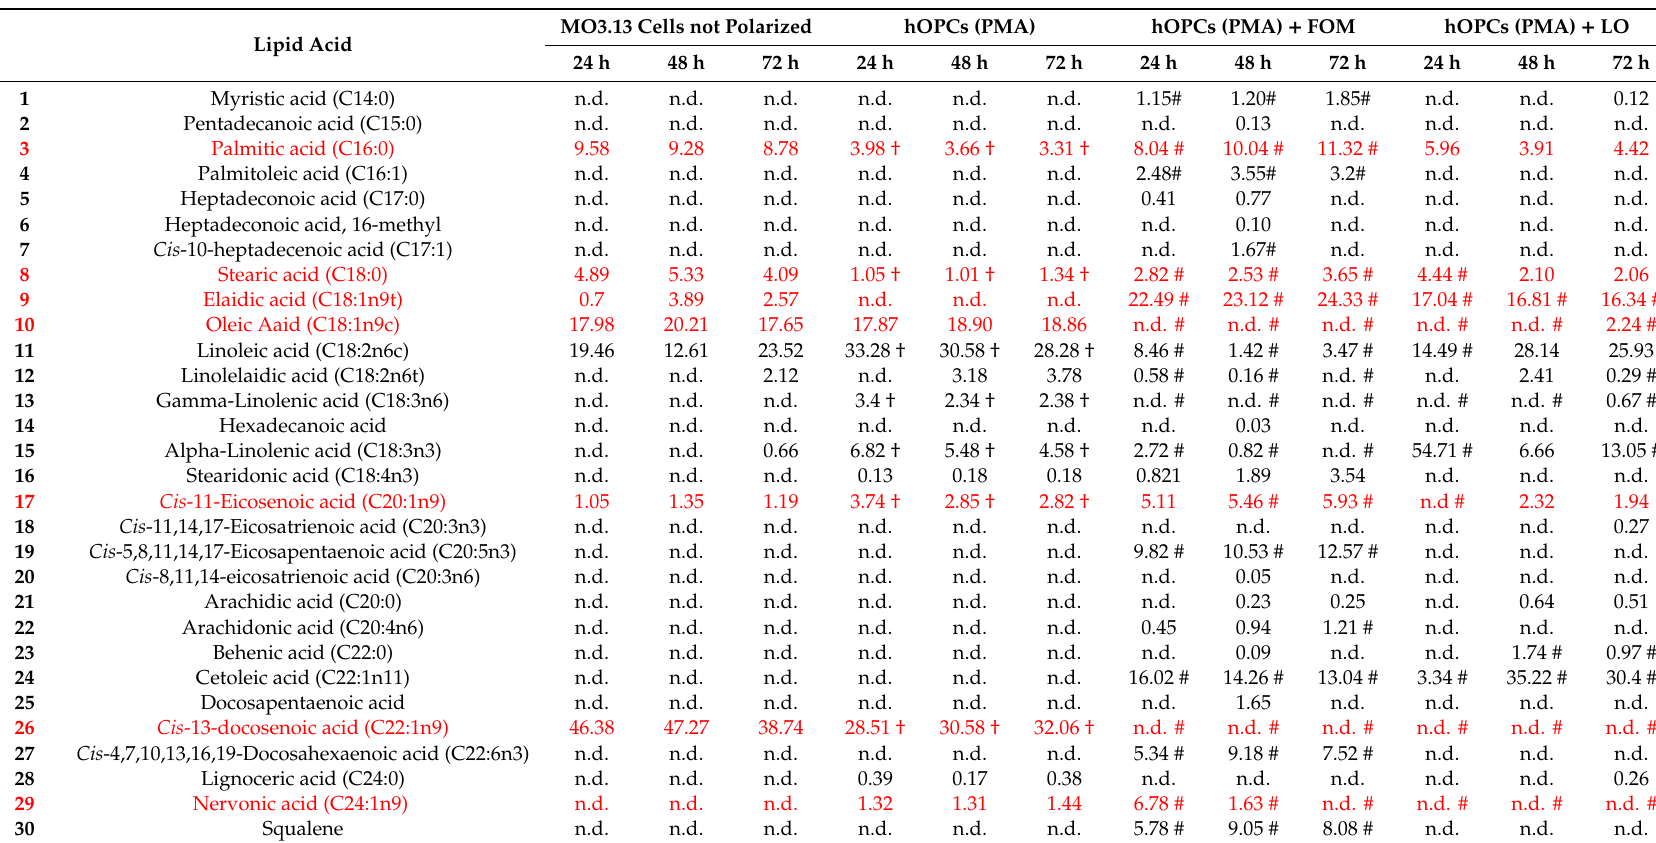
Table 2. The e ff ect of FOM and linseed oil (LO) on the lipid composition of maturing hOPC. The red color indicates the main lipids that are involved in NA synthesis or directly bind to sphingomyelin during hOPC maturation. Data are presented as the percentage of lipids from four independent experiments. Lipid Acid